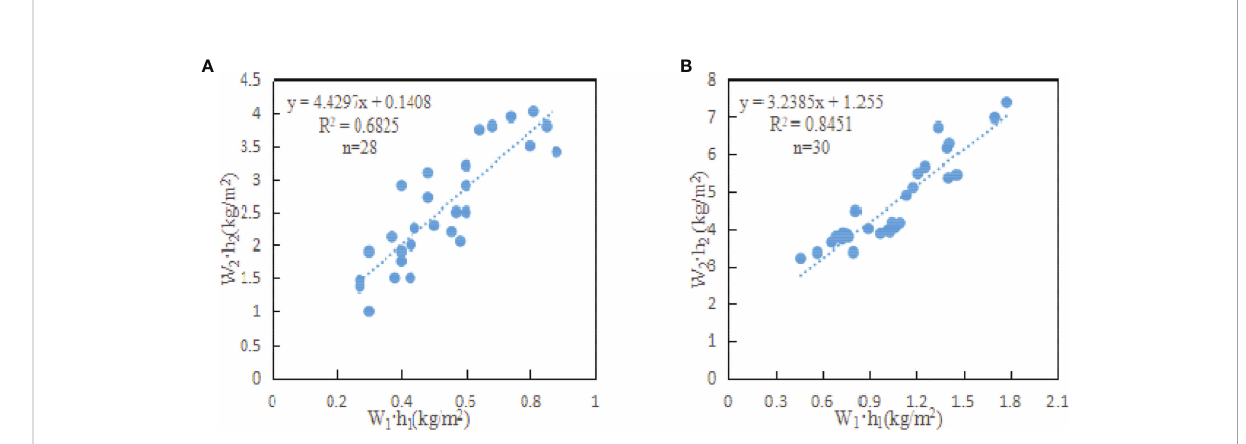
FIGURE 8 Fitting diagram of W 1 ·h 1 and W 2 ·h 2 . (A) is the fi tting diagram of W 1 ·h 1 and W 2 ·h 2 in parcel B; (B) is the fi tting diagram of W 1 ·h 1 and W 2 ·h 2 in parcel C+D+E.